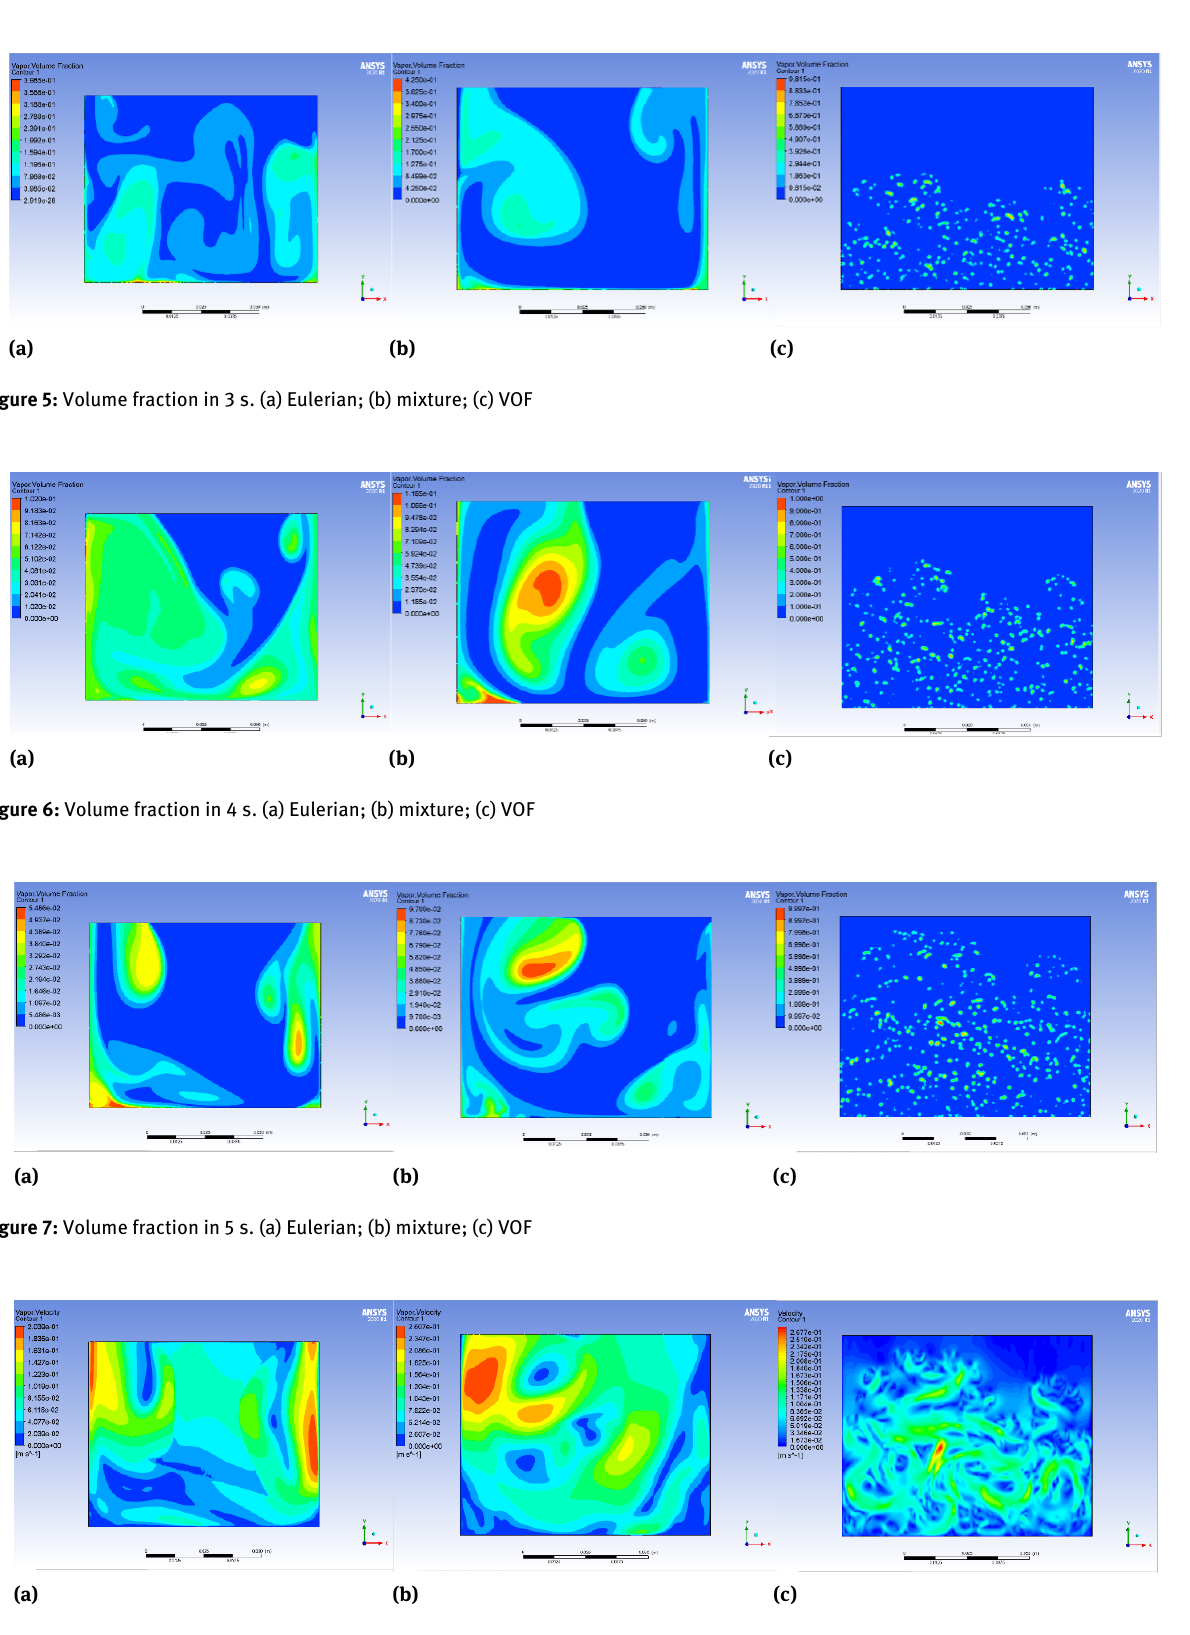
Figure 8: Velocity in 5 s. (a) Eulerian; (b) mixture; (c)